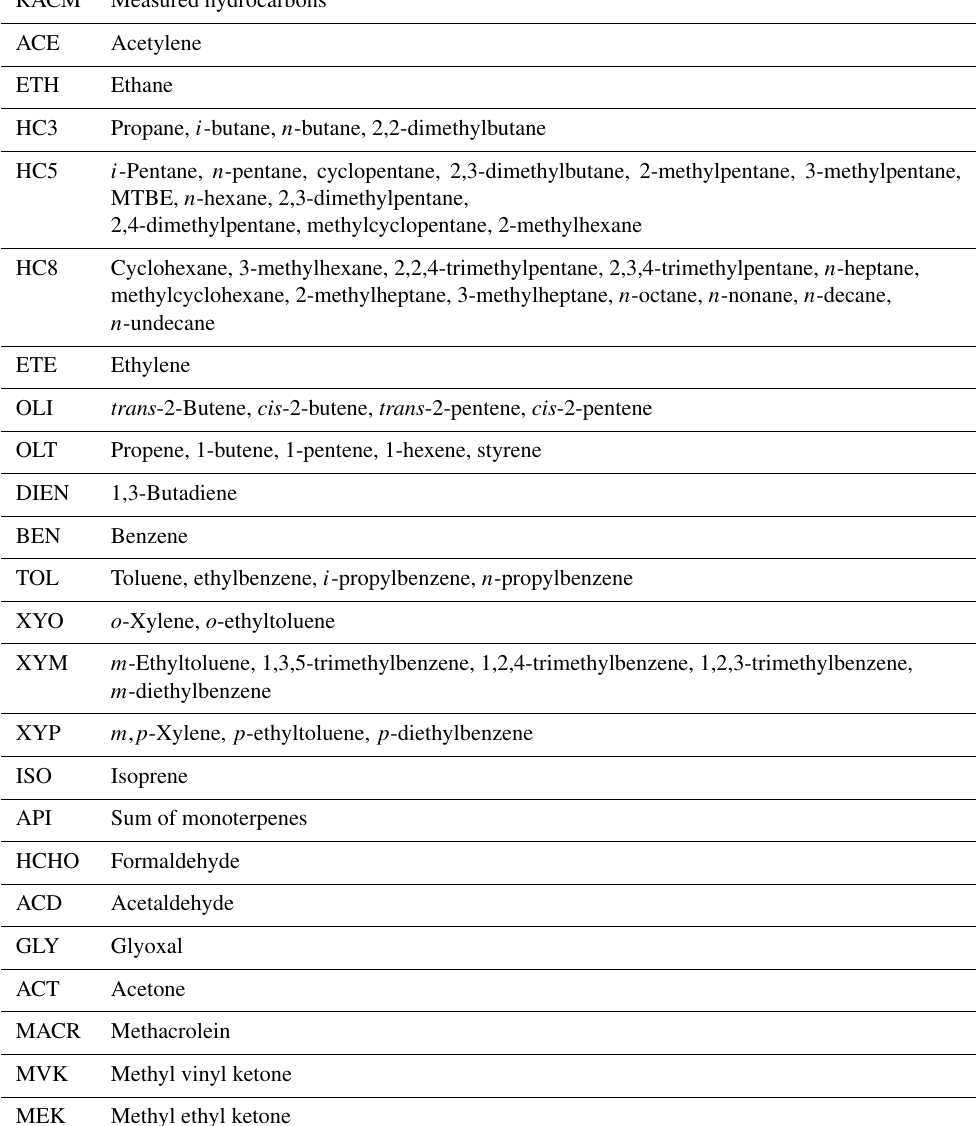
Table 2. Assignment of measured and constrained VOCs in RACM 2 during this study.